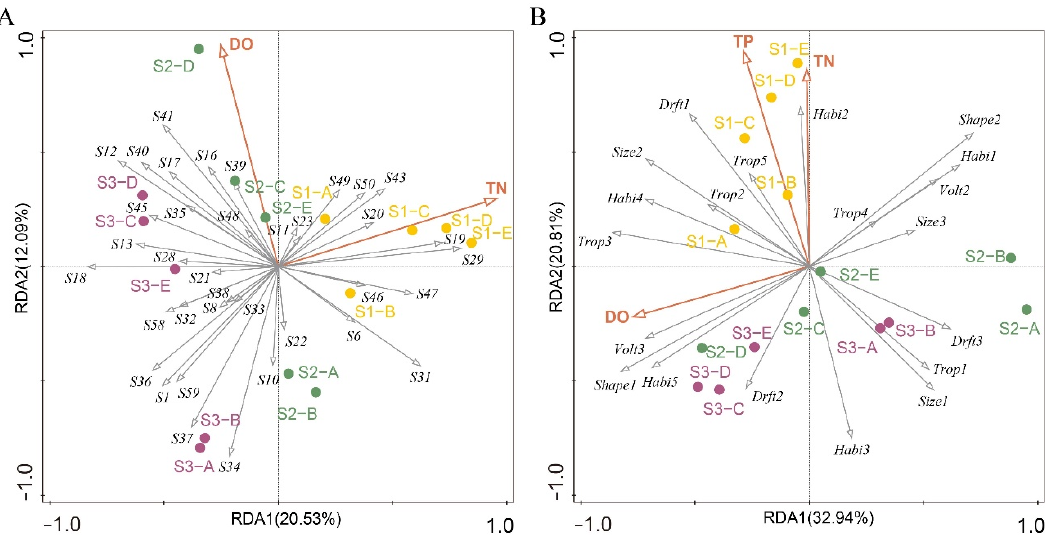
Figure 4. Redundancy analysis (RDA) ordination biplots of macroinvertebrate communities ( A ); functional traits ( B ) and main environmental factors for all sampling sites of three streams. S1: Graz ‐